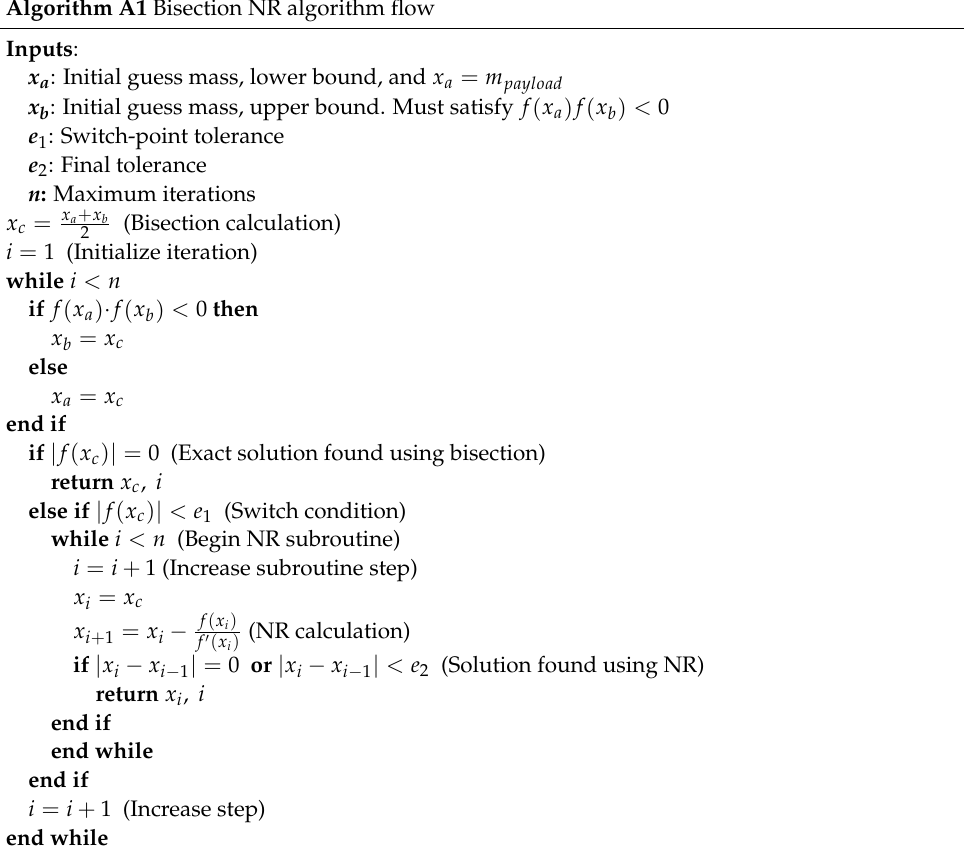
Algorithm A1 Bisection NR algorithm